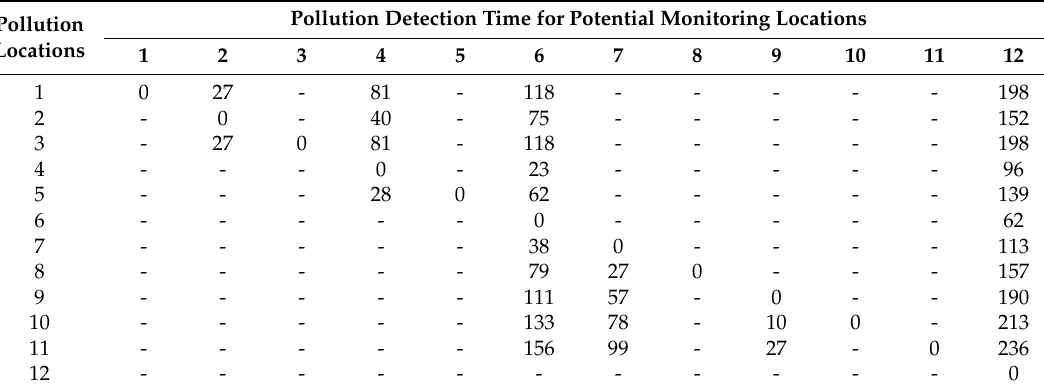
Table 2. Pollution detection time for river network A with a detection threshold of 0.01